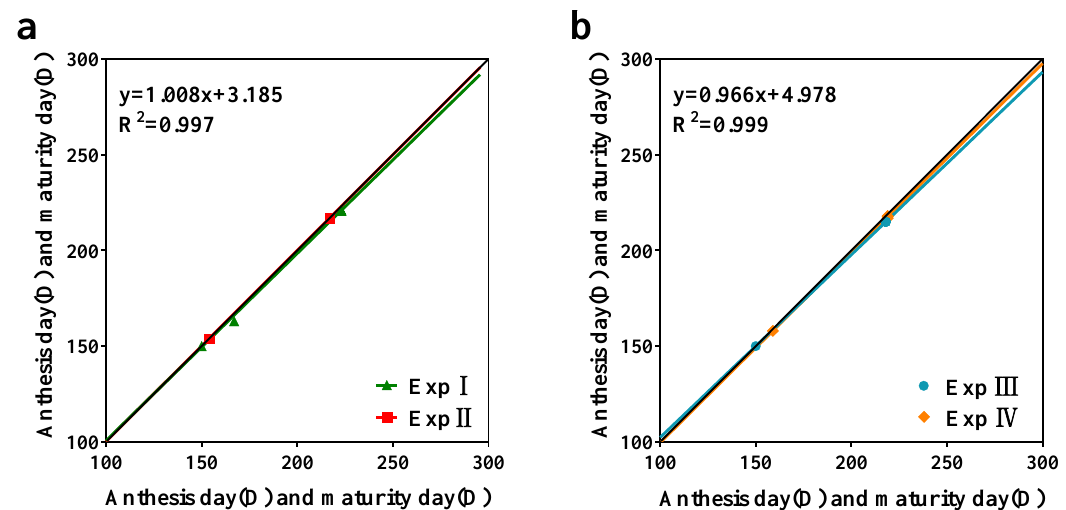
Figure 2. Relationship between simulated and measured anthesis day and maturity day for the calibration datasets I and II ( a ) and the evaluation datasets III and IV ( b ).